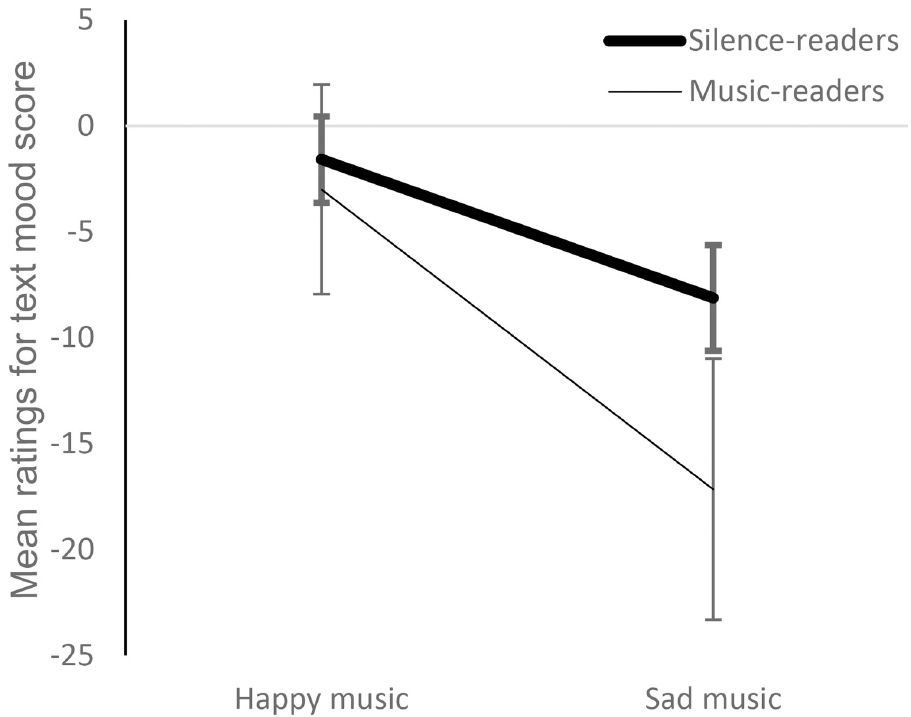
Fig 5. Mean ratings for text mood score as a function of the habit to listen to music while reading. Error bars show ± 1 SEM.